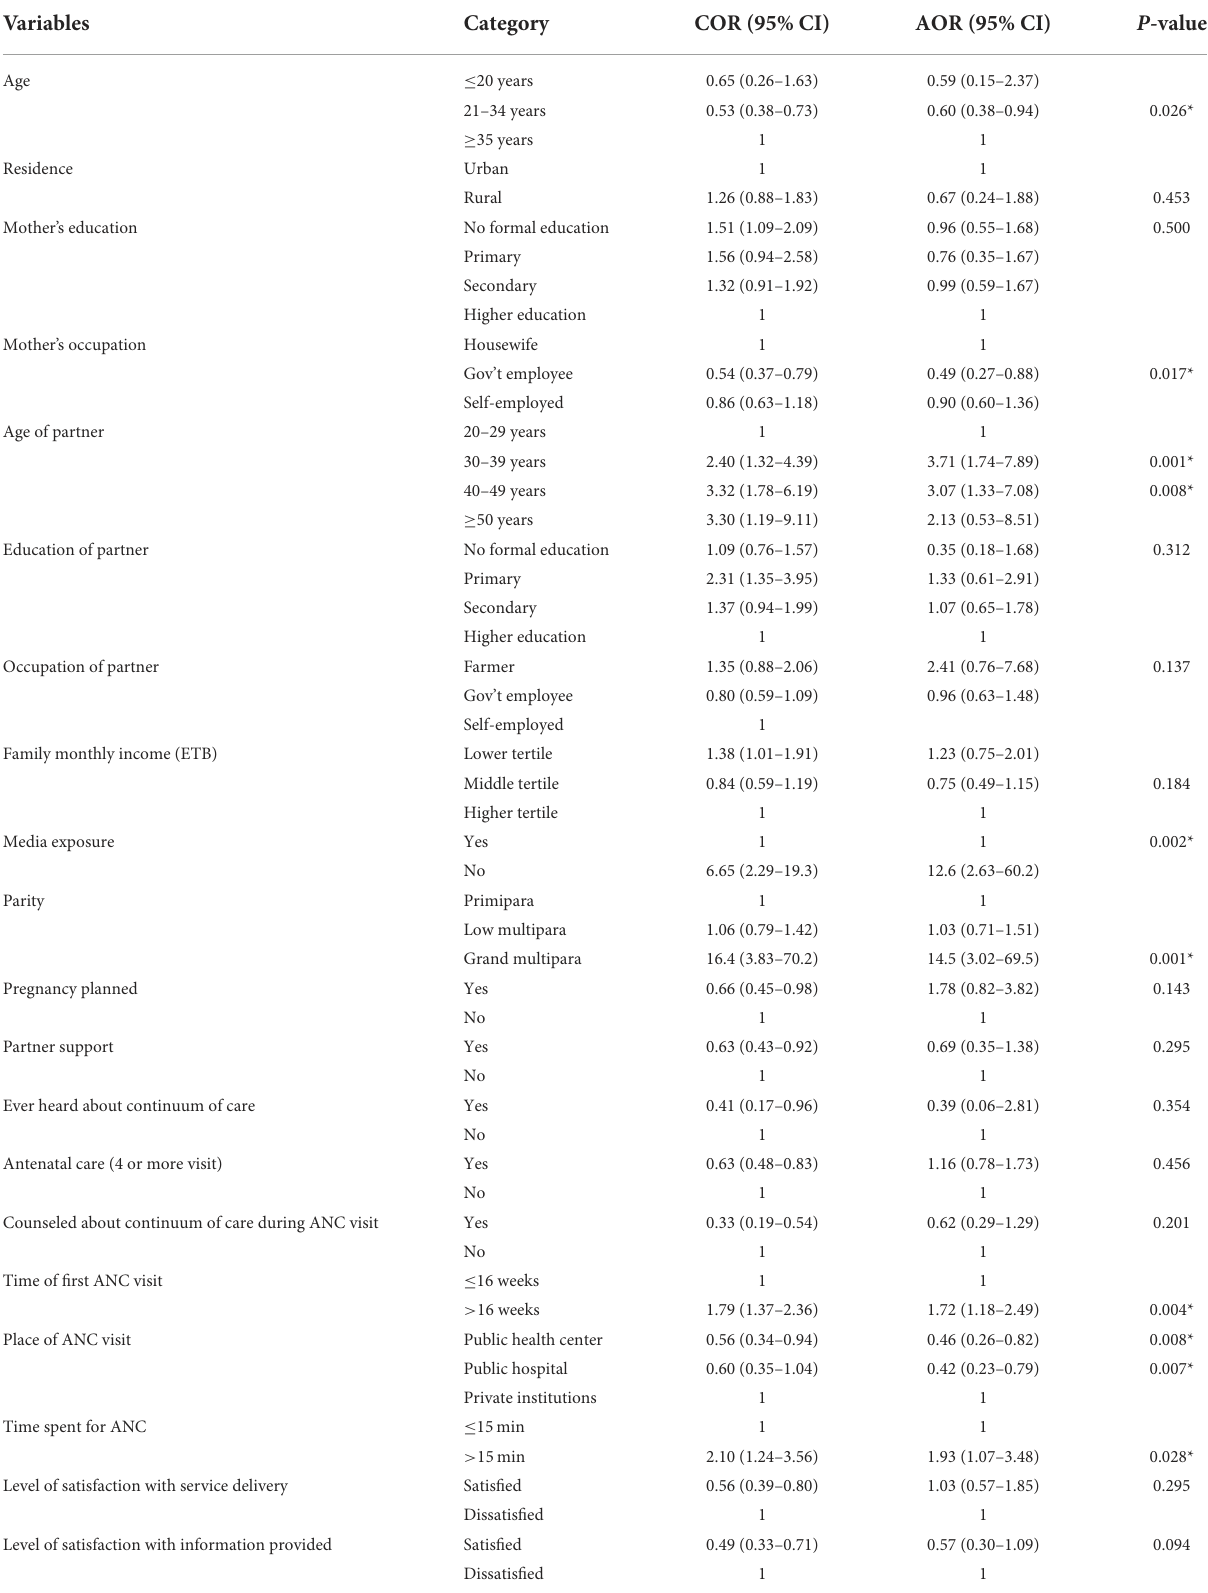
TABLE 5 Factors associated with post-natal care dropout in northeast